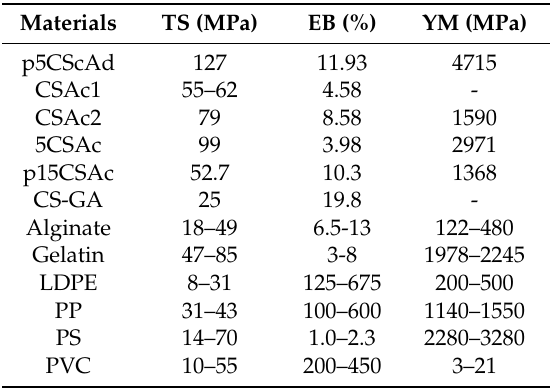
Table 3. Comparison of mechanical properties of chitosan films with several